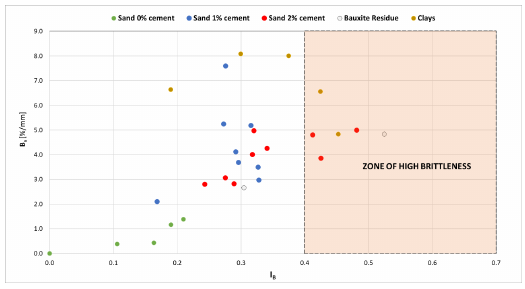
Figure 5. Structural Brittleness